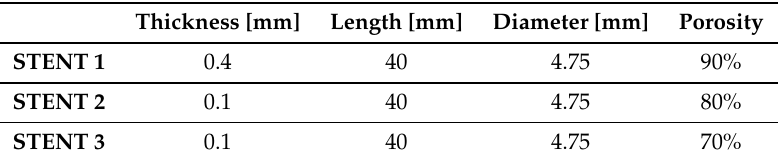
Table 1. Main dimensions of the flow-diverting stents